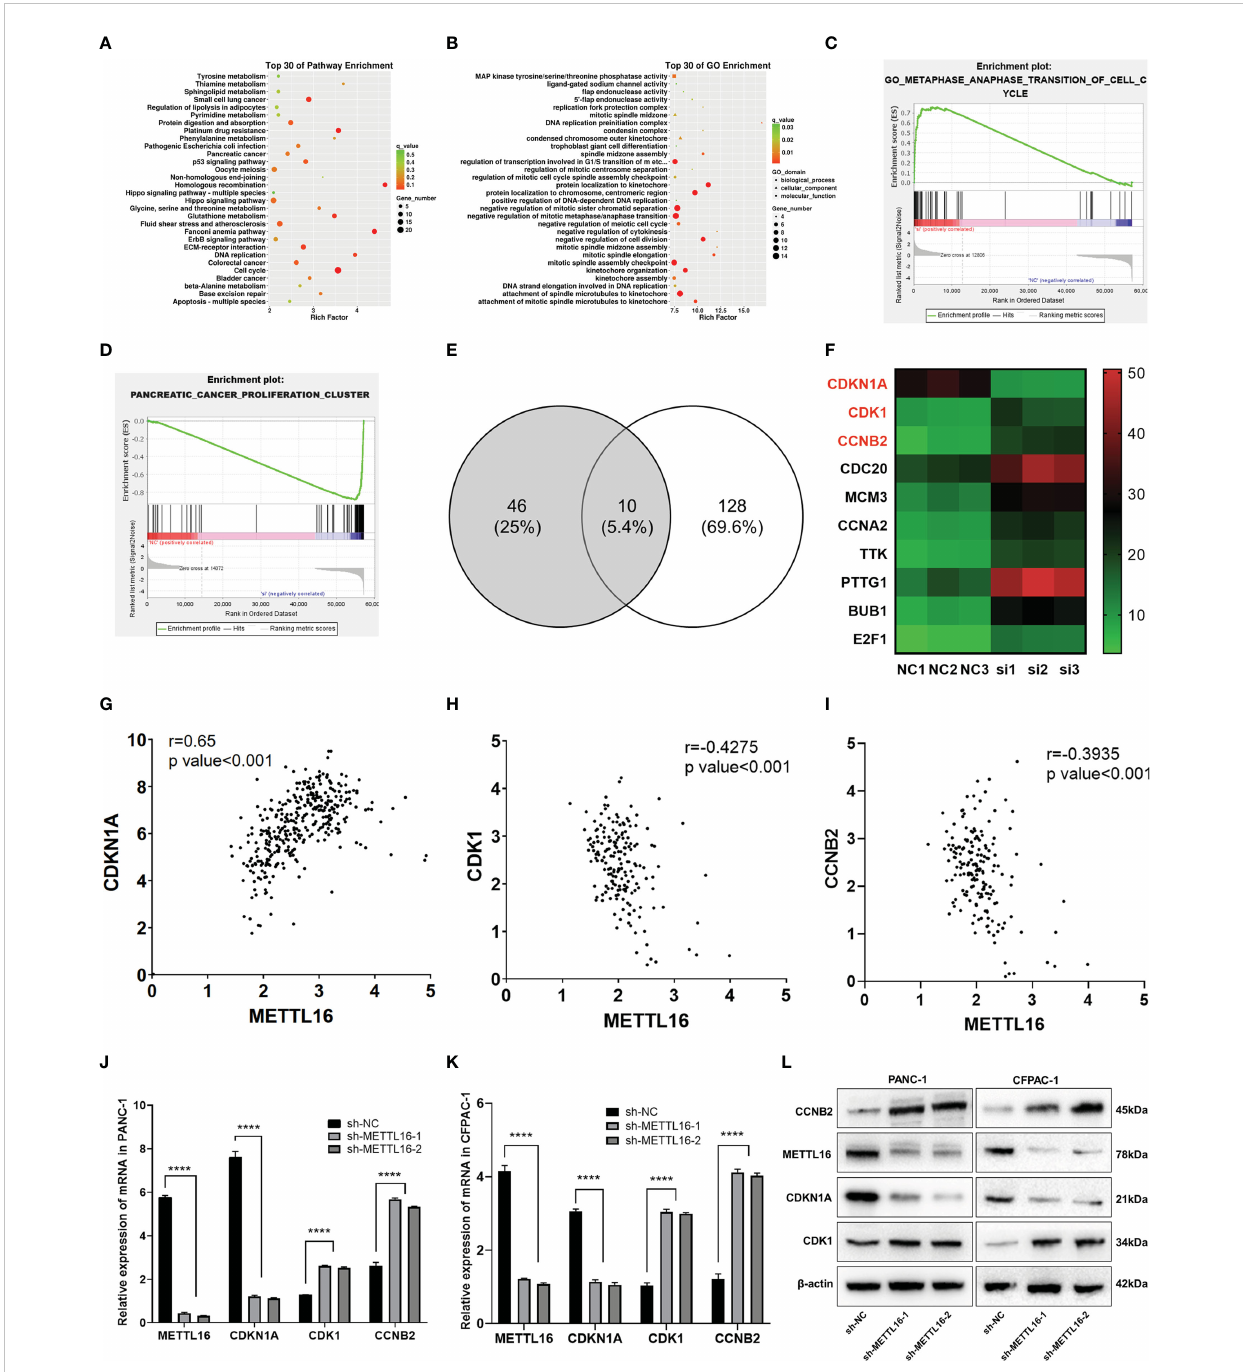
FIGURE 4 RNA-seq analysis revealed the underlying mechanisms by which METTL16 affects PC cell proliferation. (A, B) KEGG and GO analyses of METTL16- knockdown PANC-1 cells. (C, D) Gene sets related to proliferation and cell cycle signaling pathways were identi fi ed through GSEA. (E) The Venn diagram presents 10 common target genes. (F) Heatmaps of the 10 selected target genes. Analysis of the correlation of METTL16 expression with CDKN1A (G) , CDK1 (H) , and CCNB2 (I) expression was performed with TCGA data. RT − qPCR analysis of the mRNA expression of METTL16, CDKN1A, CDK1 and CCNB2 in PANC-1 (J) and CFPAC-1 (K) cells was performed. (L) Western blotting analysis was performed to detect the expression of proteins associated with METTL16, CDKN1A, CDK1 and CCNB2 in PANC-1 (left) and CFPAC-1 (right) cells. **** means